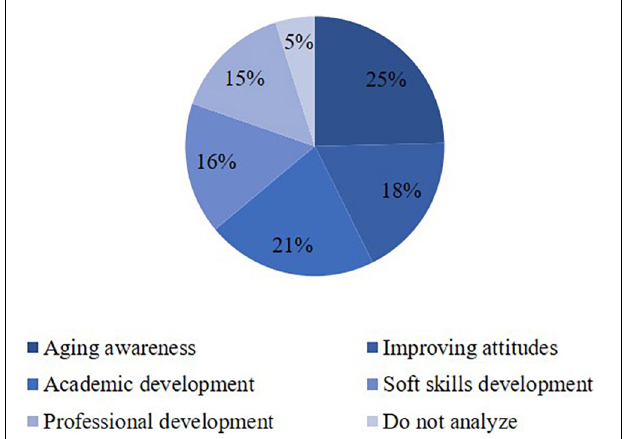
FIGURE 2 | Frequency of coded segments in each category: students’